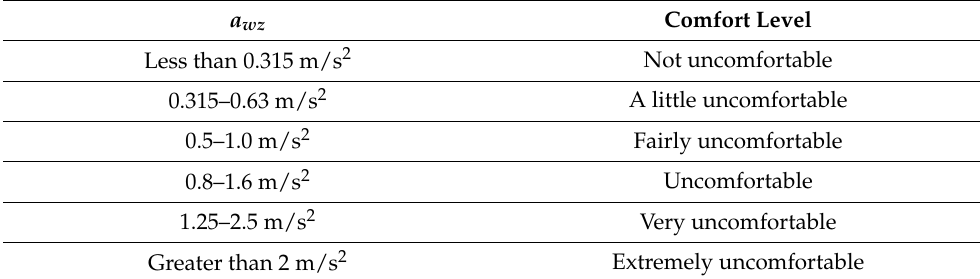
Table 3. Comfort levels related to a wz threshold values proposed by ISO 2631-1.